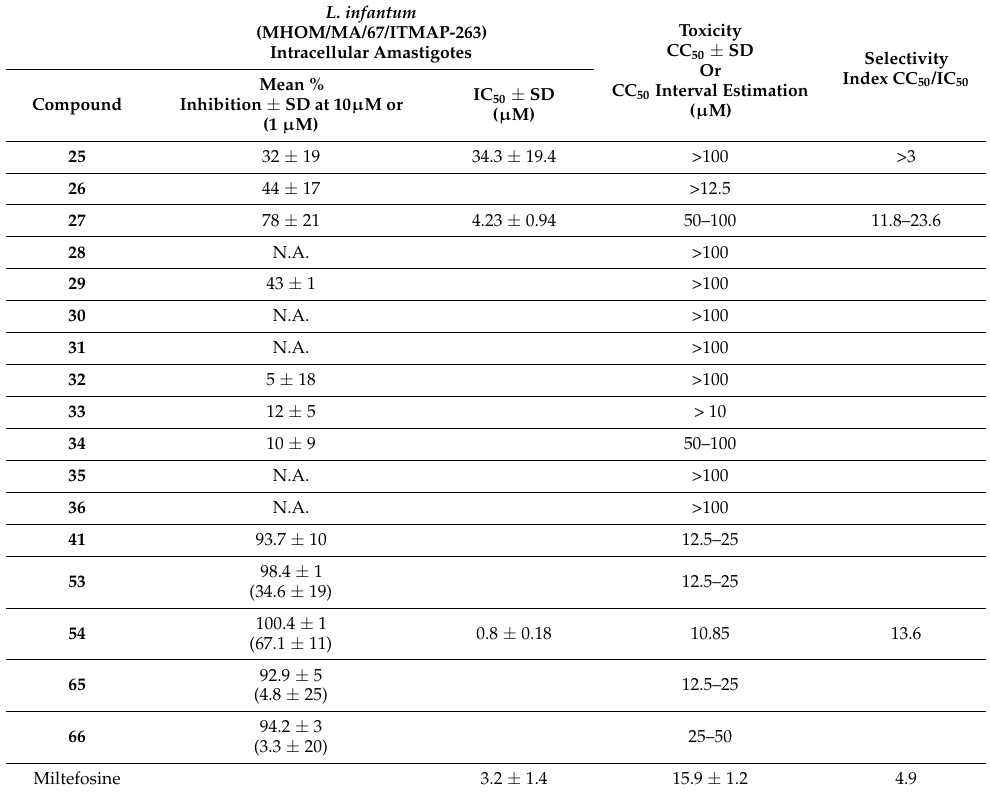
Table 1. In vitro evaluation of antiparasitic activity against L. infantum (MHOM/MA/67/ITMAP-263) intracellular amastigotes, cytotoxicity against PMA-differentiated THP-1 cells and selectivity index. L. infantum (MHOM/MA/67/ITMAP-263) Intracellular